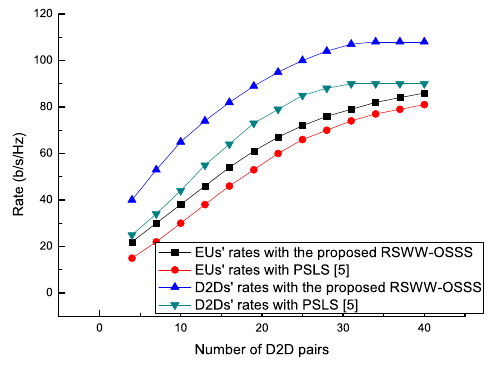
Figure 3. Sum-rate of EUs and D2D pairs versus different numbers of D2D transmission pairs when the number of EUs is 20.